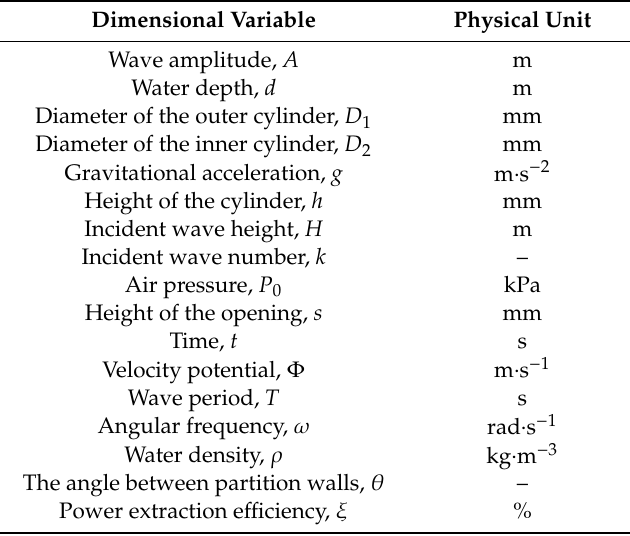
Table 1. Outline of dimensional variables.